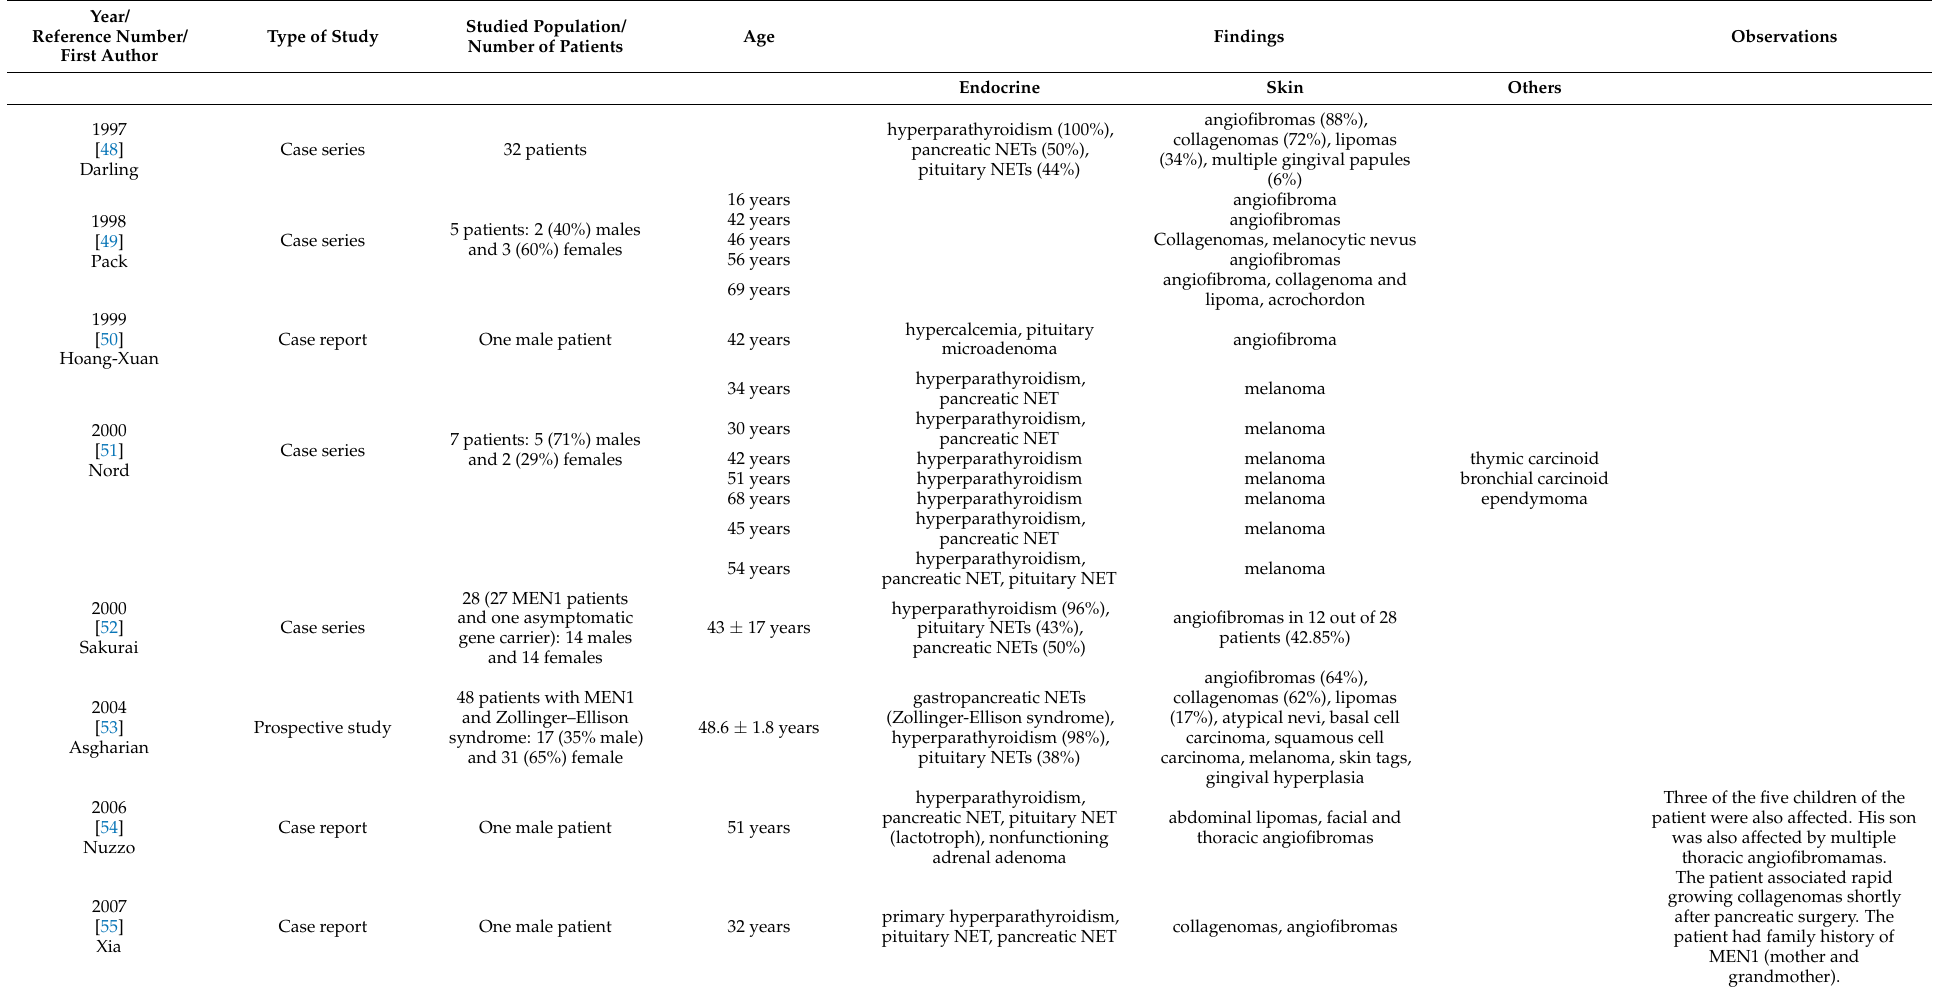
Table 1. Cutaneous findings in patients with MEN1 syndrome. Please see references